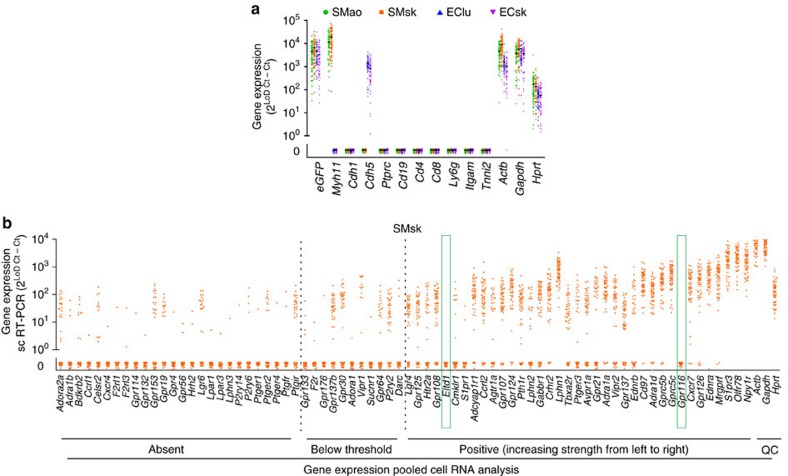
Single-cell RT-PCR analysis in freshly isolated vascular cells.EC or SMC obtained from skeletal muscle vasculature (sk), lung (lu), aorta (ao) of Cdh5-Crepos; dTom/EGFP-reporterpos mice (Cdh5-EGFP) and tamoxifen-treated Myh11-CreERT2pos; dTom/EGFP-reporterpos mice (Myh11-EGFP), respectively, were subjected to single-cell RT-PCR. (a) Expression of identity-defining genes and quality control genes (Gapdh, Hprt and Actb) after exclusion of contaminating cells or marker negative cells (each dot one cell). (b) Comparison of expression data obtained by multiplex RNA expression analysis in pooled SMsk and single-cell RT-PCR (sc RT-PCR) in individual SMsk. GPCRs are arranged on the abscissa according to their expression strength in pooled RNA analysis, the ordinate shows the strength of gene expression in individual cells (each dot one cell). Green boxes indicate genes negative in sc RT-PCR but positive in pooled RNA analysis (cell/animal numbers: sc RT-PCR: n=57 cells from seven mice; pooled RNA analysis: 500 ng from 106 cells per six mice. Values of genes that are not expressed were scattered around 0 to allow graphical estimation of cell counts). Expression data are calculated as follows: Gene expression=2(Limit of detection(LoD) Ct—sample Ct); LoD Ct is set to 24.